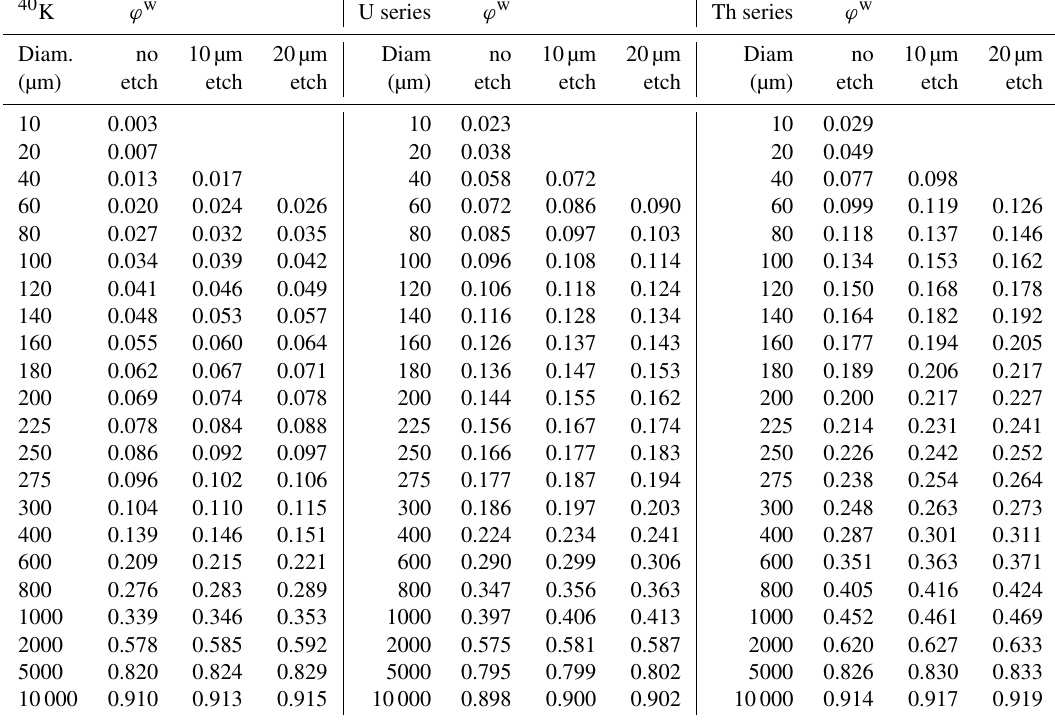
Table 1. Quartz self-dose values for whole-grain sources, ϕ w .